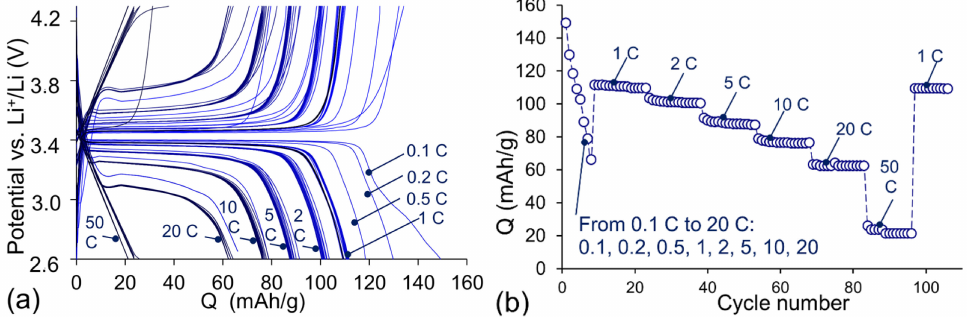
Figure 2. ( a ) Galvanostatic charge-discharge curves, ( b ) variation of capacity with the cycle number. The values of the charge and discharge currents (C rate -units) are on the